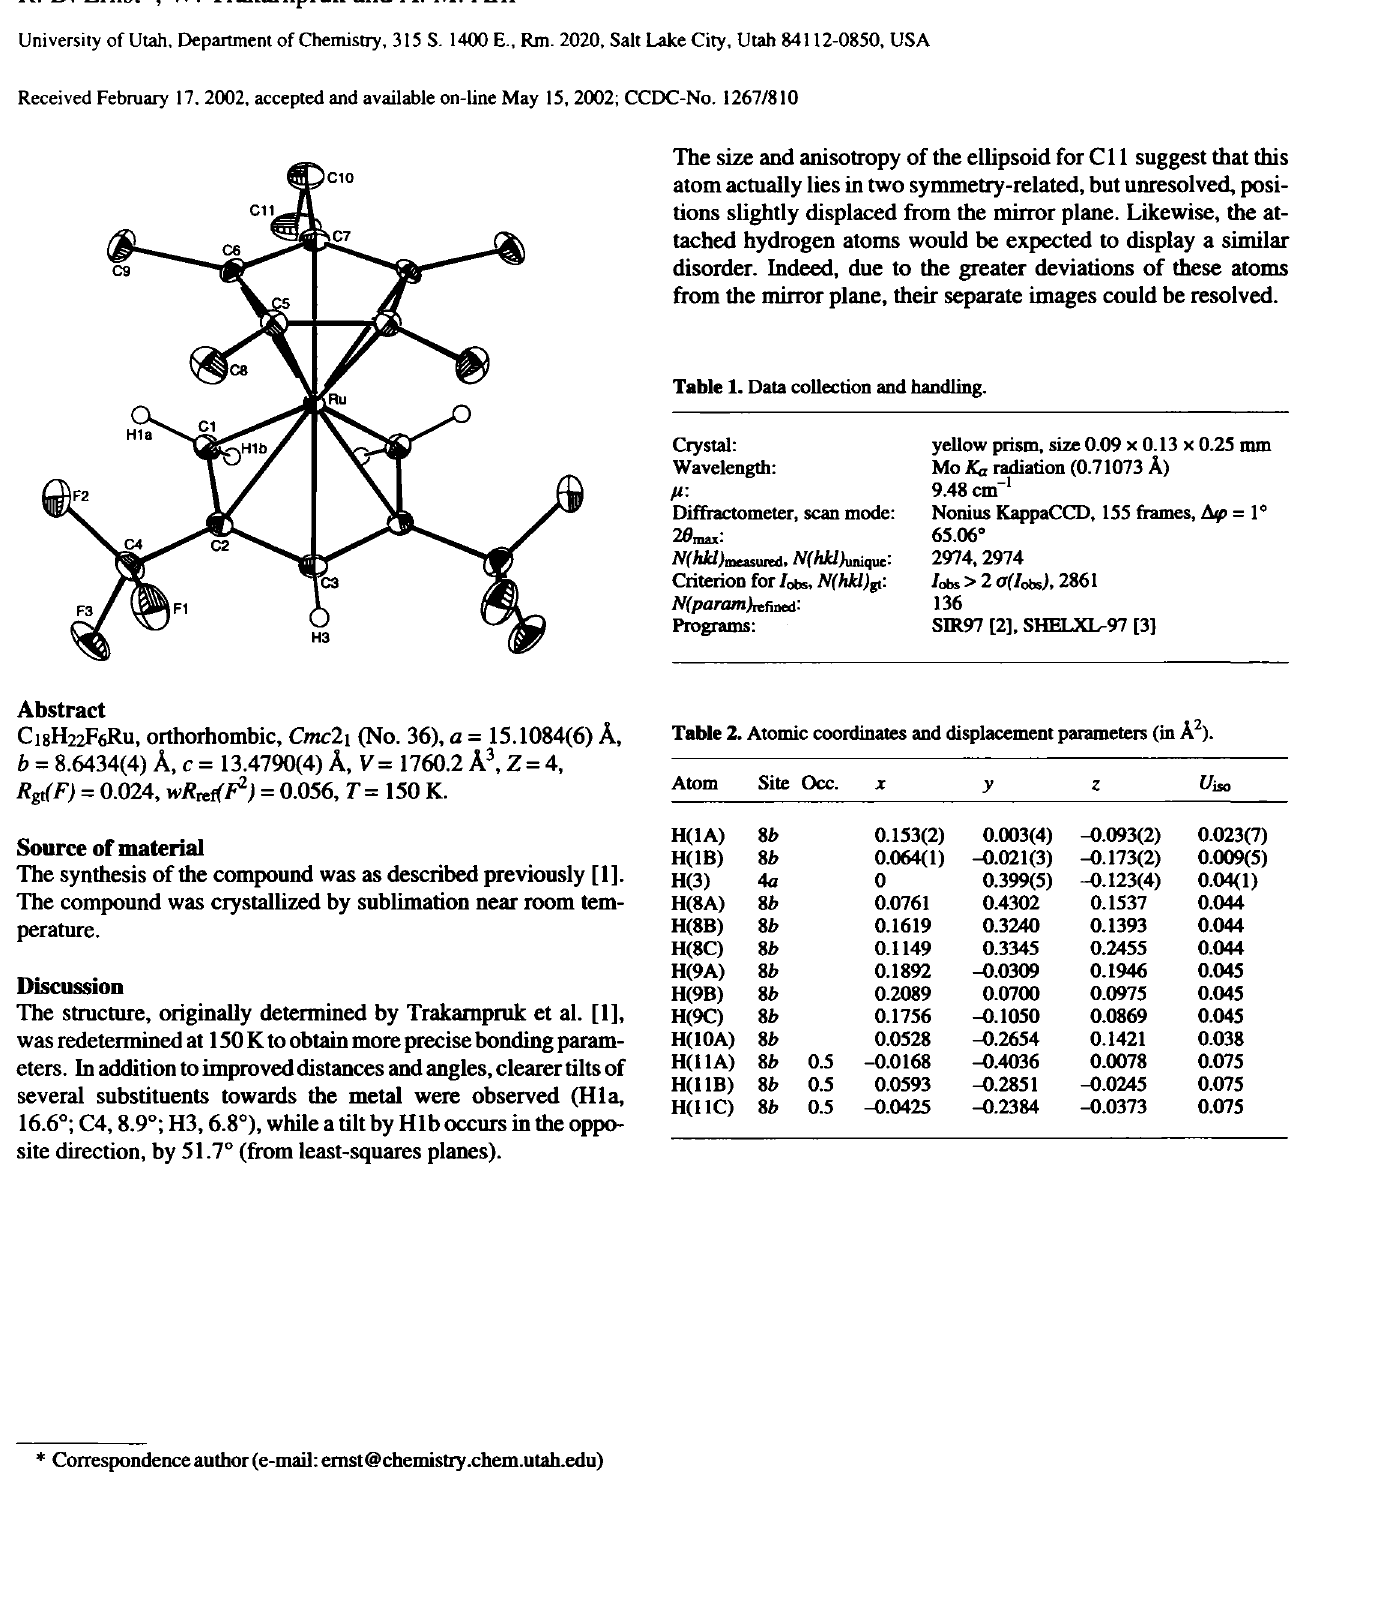
Table 2. Atomic coordinates and displacement parameters (in Â 2